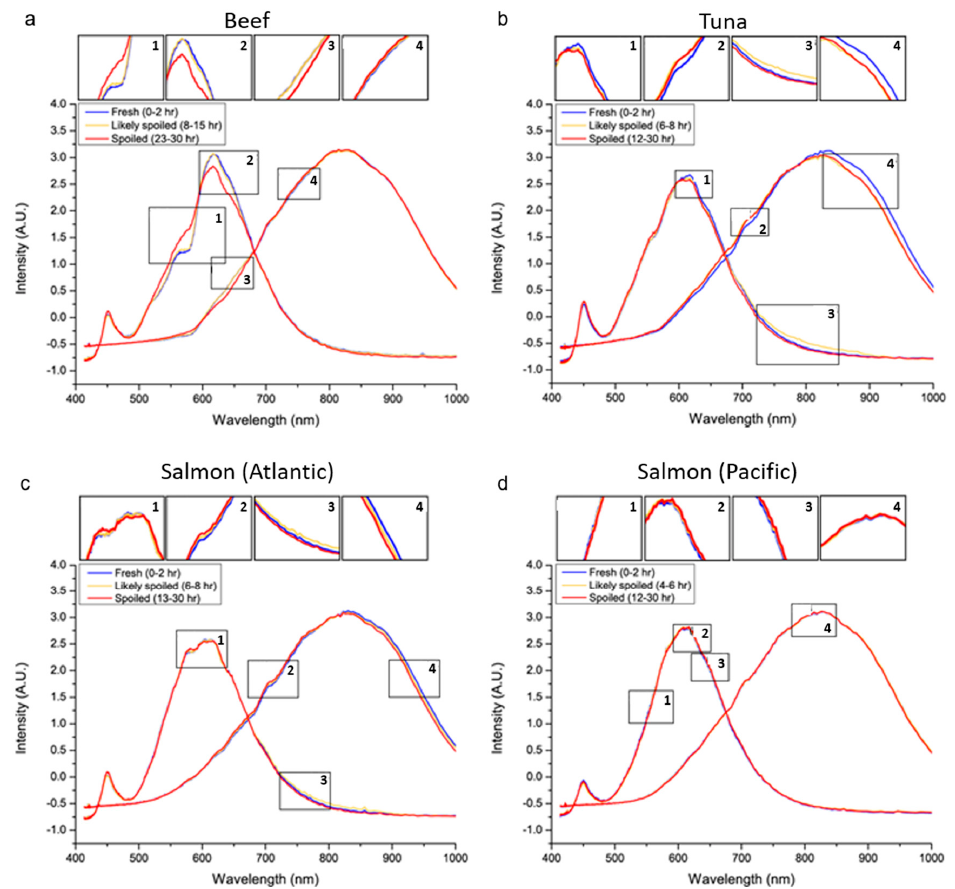
Figure 5. Spectral responses reflecting states of food freshness: ( a ) beef, ( b ) tuna, ( c ) Atlantic salmon, and ( d ) Pacific salmon. Average spectrum over 1000 spectra per each state after Standard Normal Variate (SNV) transformation are shown in the plots. Blue lines are for “Fresh”, yellow lines are for “Likely Spoiled”, and red lines for “Spoiled” samples. The lines with the maximum peak around 600 nm are the reflected spectrum of the LED light, and the lines with the peak around 800 nm are the reflected spectrum of the bulb light. For each plot, four areas with significant differences between the graphs are enlarged above for illustration purposes.